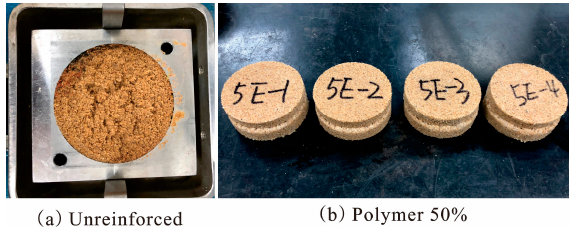
Figure 11. The shape of specimens after direct shear test.